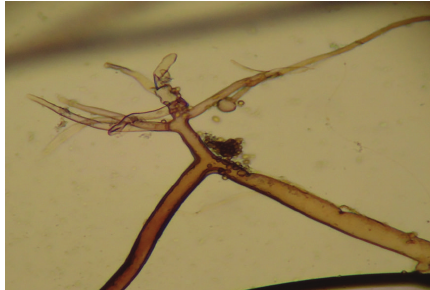
Figure 20: Rhizopus arrhizus in microculture, isolated from first sample of tissue nasal sinus debridement in patient from Figure 19 × 400